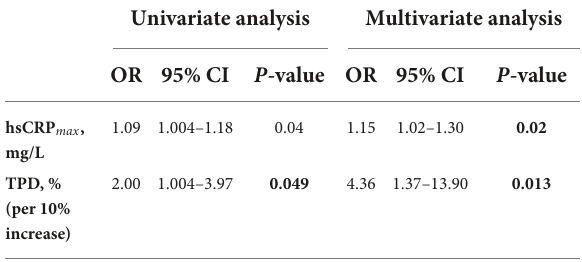
TABLE 2 Univariate and multivariate regression analysis for the presence of cardiogenic